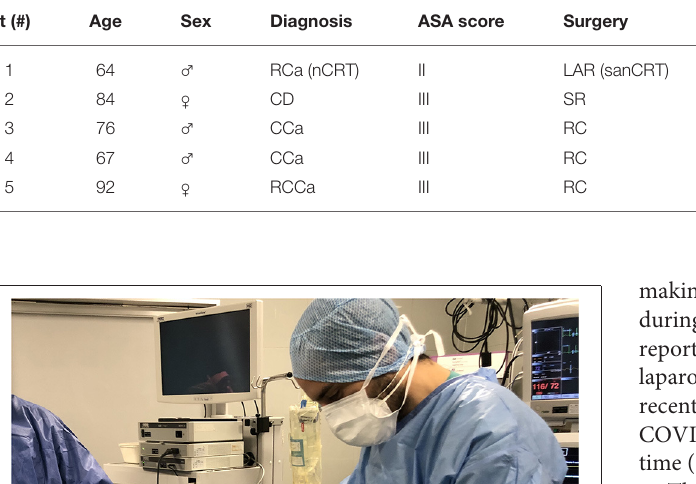
TABLE 1 | Patients’ clinico-pathological characteristics and intraoperative results.